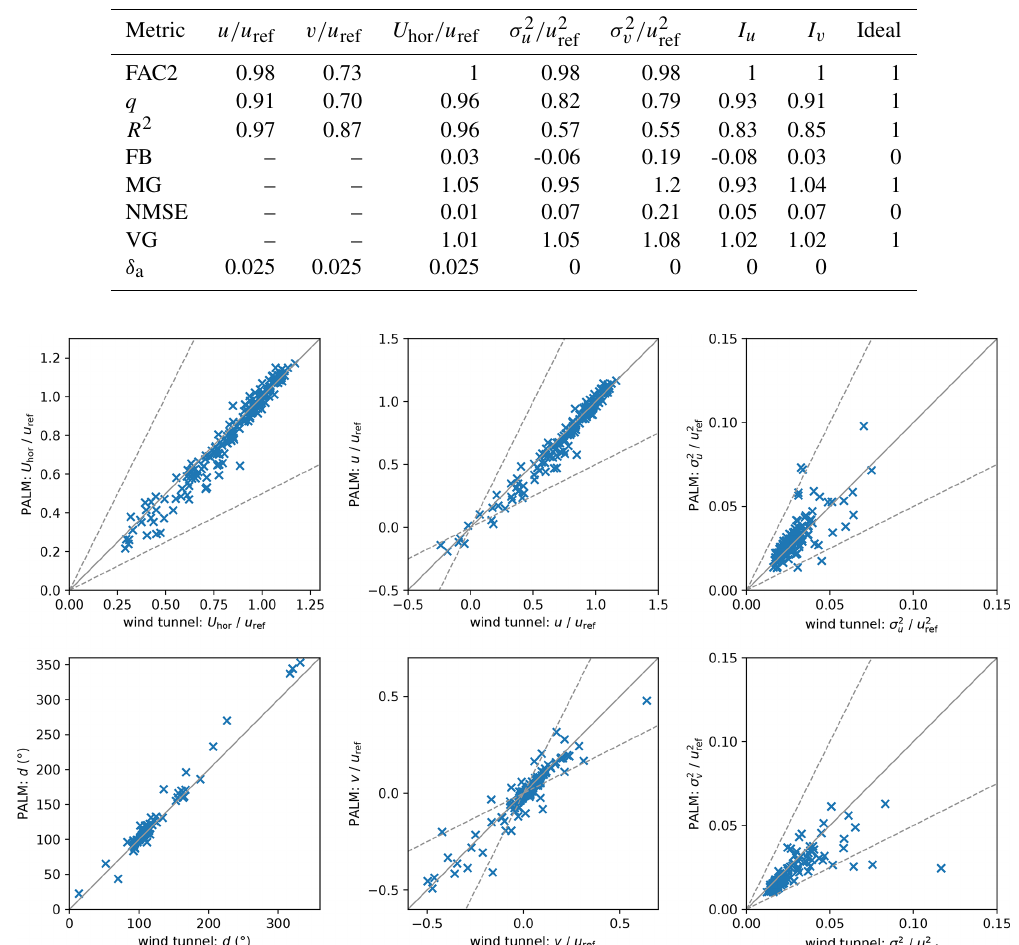
Table 1. Calculated validation metrics for different variables. The rightmost column gives the respective value of a perfect match between simulation and observation.